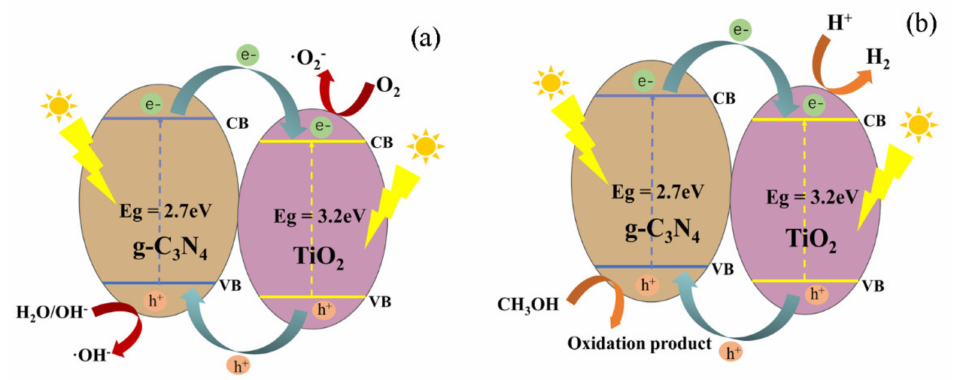
Figure 10. Photocatalytic degradation by ( a ) and hydrogen production ( b ) mechanism of g-C 3 N 4 /TiO 2